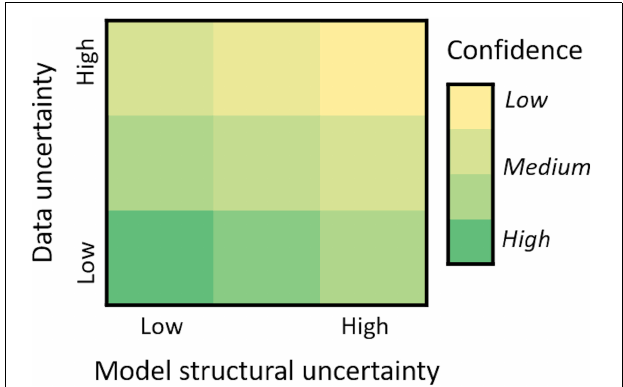
FIGURE 3 | Evaluation of confidence in ecosystem model climate projections based on expert judgment of (1) data uncertainty considering data availability, quality and fitting, and (2) model structural uncertainty reflecting the climate drivers and spatial and processes resolution of different model